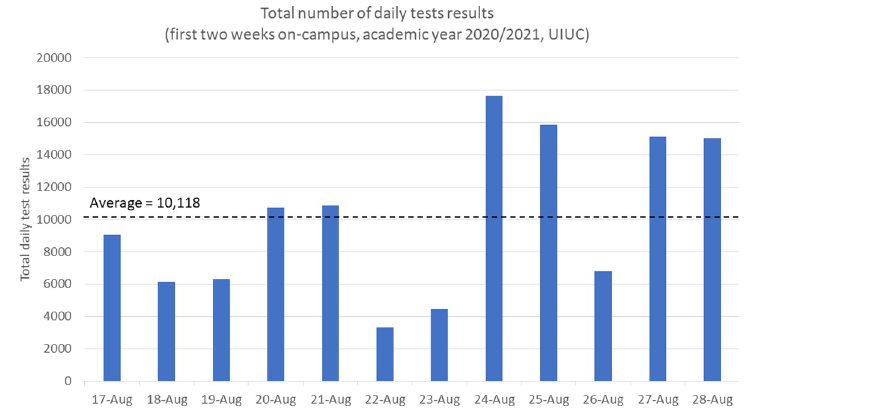
Fig 8. Variability of the number of persons being tested on a daily basis (source: